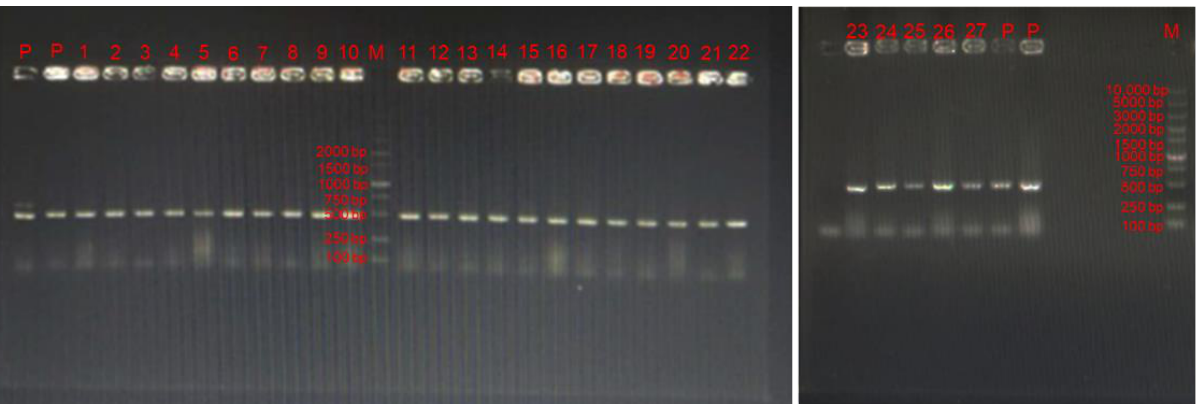
Figure 1. The specific-PCR detection of 27 bacterial isolates. “P” represents positive LAB (LGG). “M” represents the DNA marker. Numbers 1–27 are strains selected in the present study.